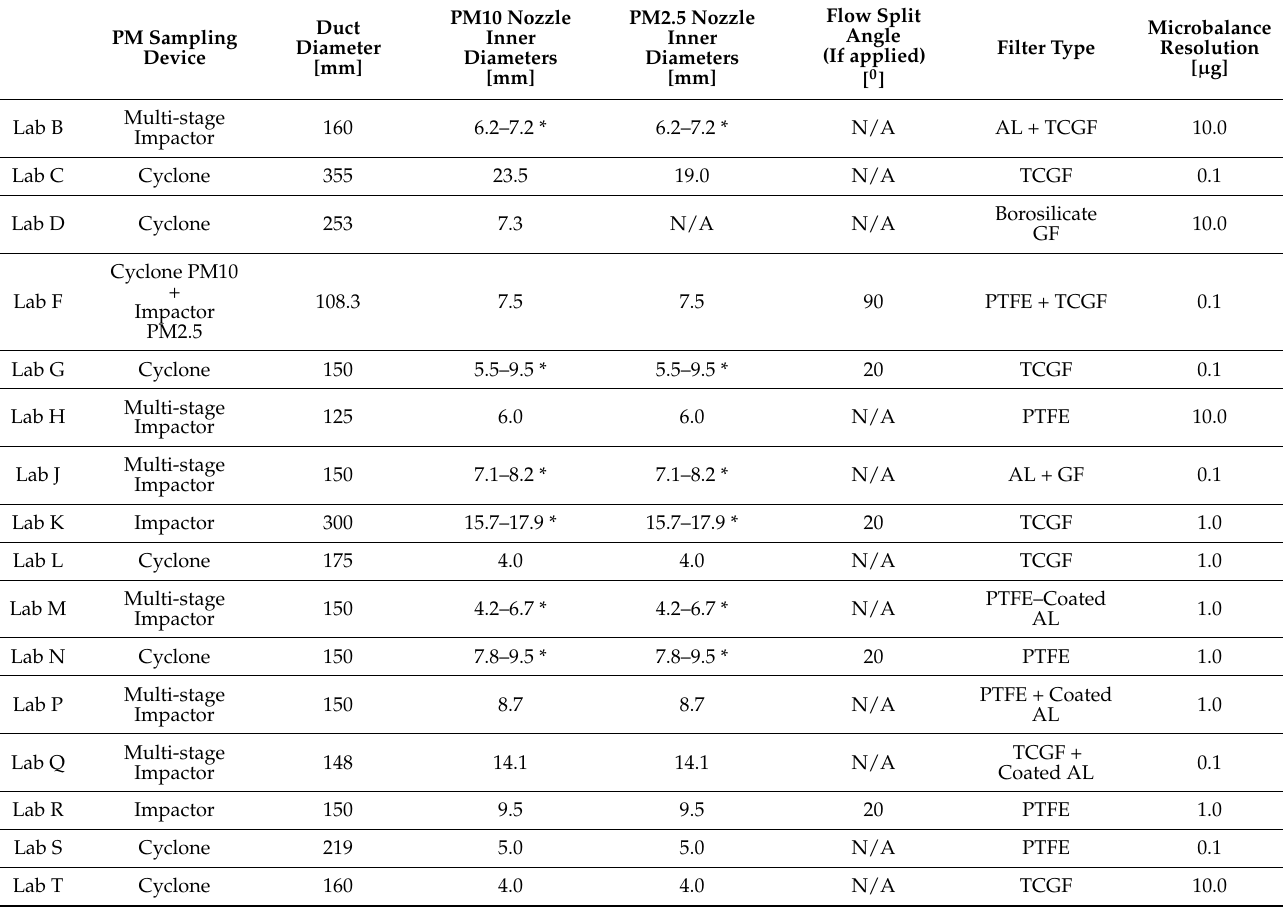
Table 3. Main characteristics of PM-related instrumentation used at the